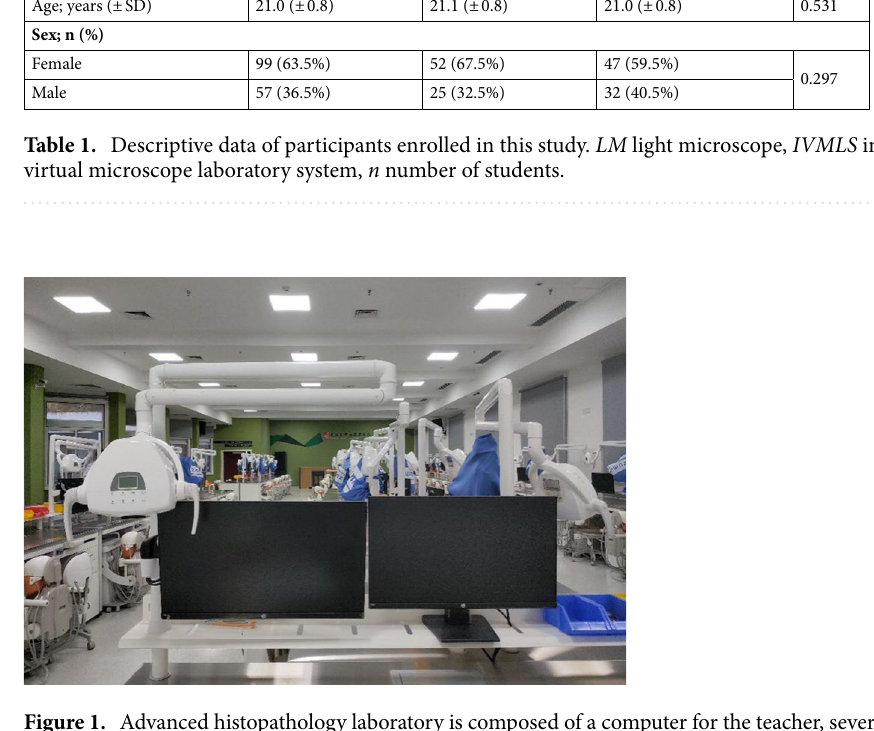
Figure 1. Advanced histopathology laboratory is composed of a computer for the teacher, several computers for students, interactive virtual microscope laboratory system (IVMLS) and other auxiliary